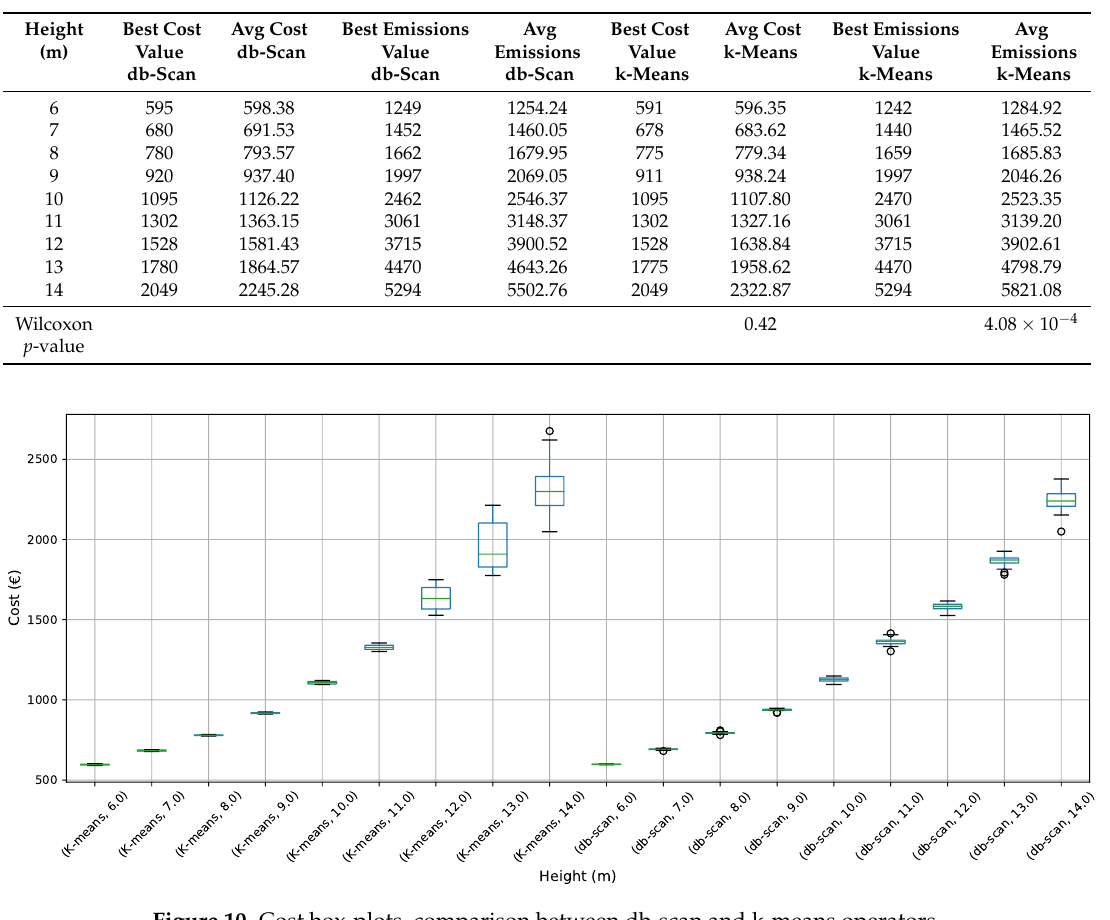
Figure 10. Cost box-plots, comparison between db-scan and k-means